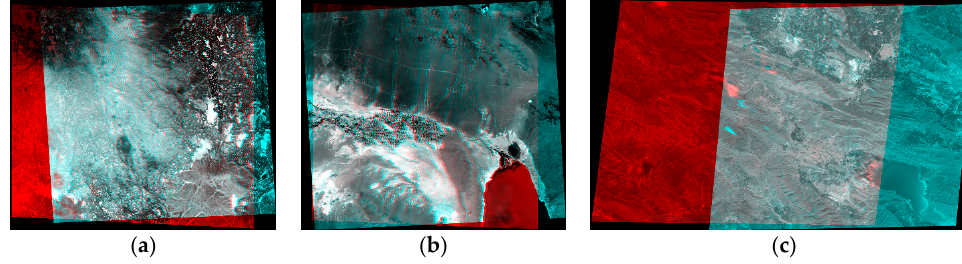
Figure 7. Stereo anaglyphs of the normalized scenes through the Experiments 2, 6, and 10: ( a ) Isfahan dataset; ( b ) Zanjan dataset; ( c ) Fars dataset.